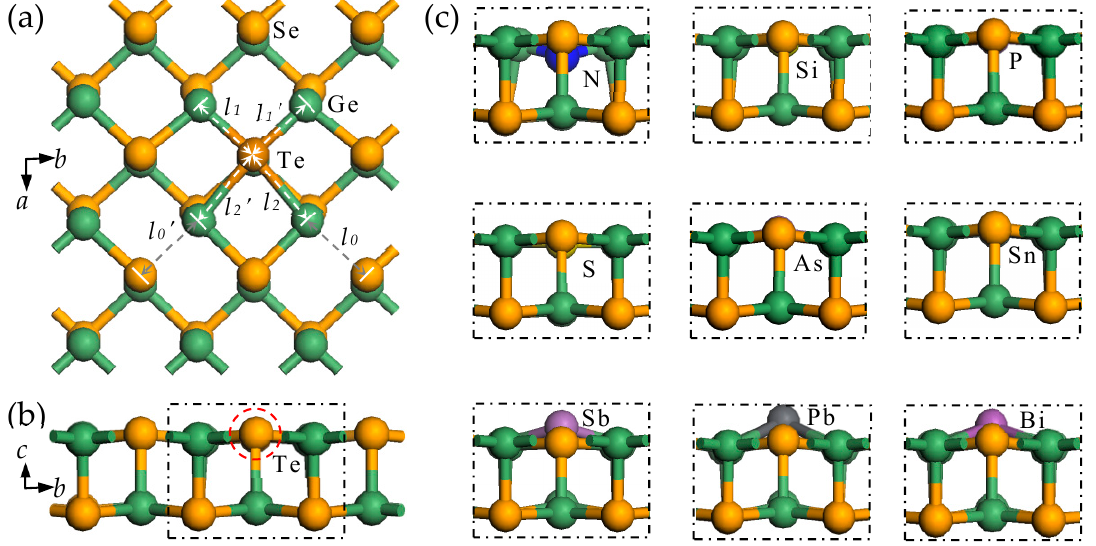
Figure 2. ( a , b ) Top and side view of GeSe monolayer doped by a Te atom. ( c ) A part of the side view of each doped GeSe model by one of group IV–VI atoms.